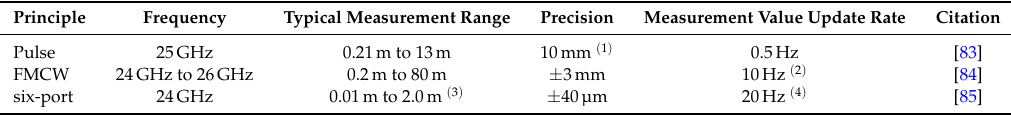
Table 2. Typical values for commercially available radar sensors for distance measurements and ranging taken from representative product manuals (see the